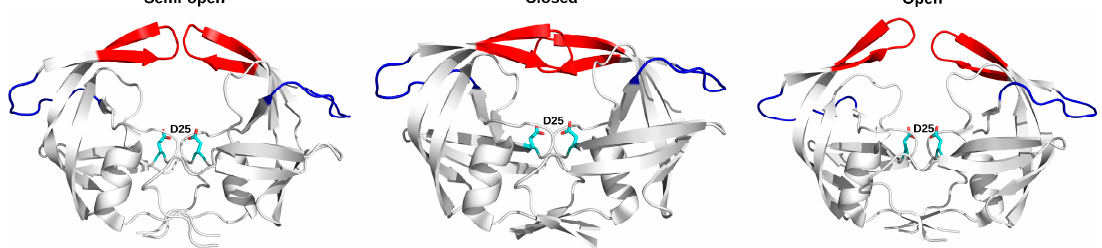
Figure 2. Conformational states experienced by HIV ‐ 1 PR as it proceeds through its catalytic cycle. Crystal structures of HIV ‐ 1 PR in the semi ‐ open (PDB 1HHR), closed (PDB 1HVR) and wide open (PDB 1TW7) conformations. The catalytic Asp25 residues from each protomer are depicted as cyan sticks and the “flaps” are depicted in red. The hinge loop, corresponding to residues 34–42, is shown in blue. The curled/tucked conformation of HIV ‐ 1 PR is not depicted, since it has never been crystallographically resolved.